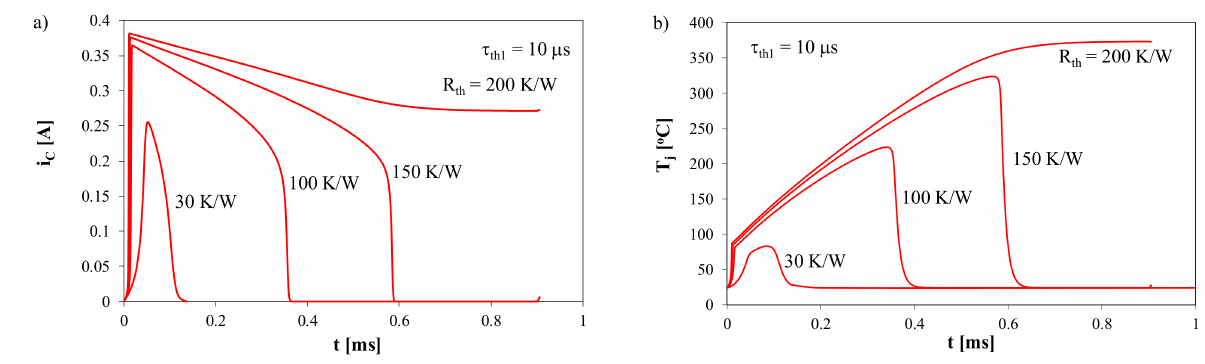
Figure 9. Collector current ( a ) and junction temperature ( b ) of the BJT with different values of its thermal resistance. In Figure 10 the influence of the electrical capacitances in the model of the BJT is illustrated.